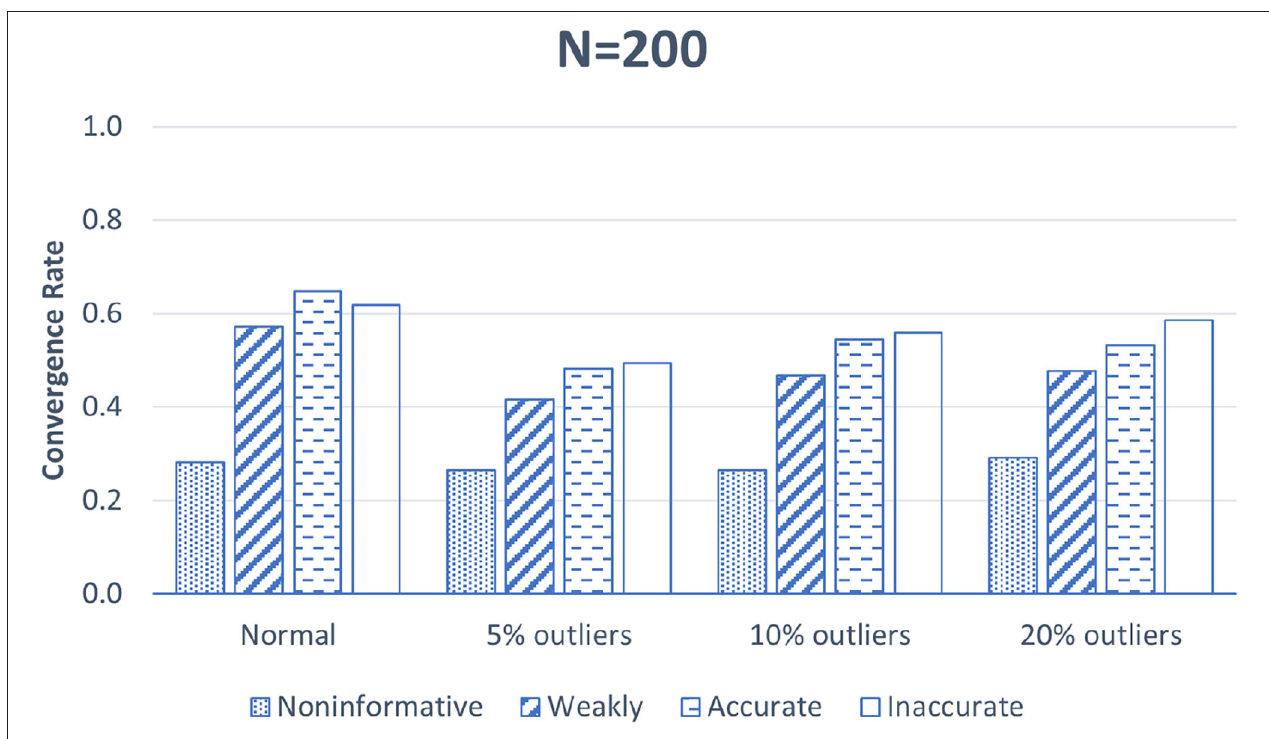
FIGURE 2 | Convergence rate for different priors when N =